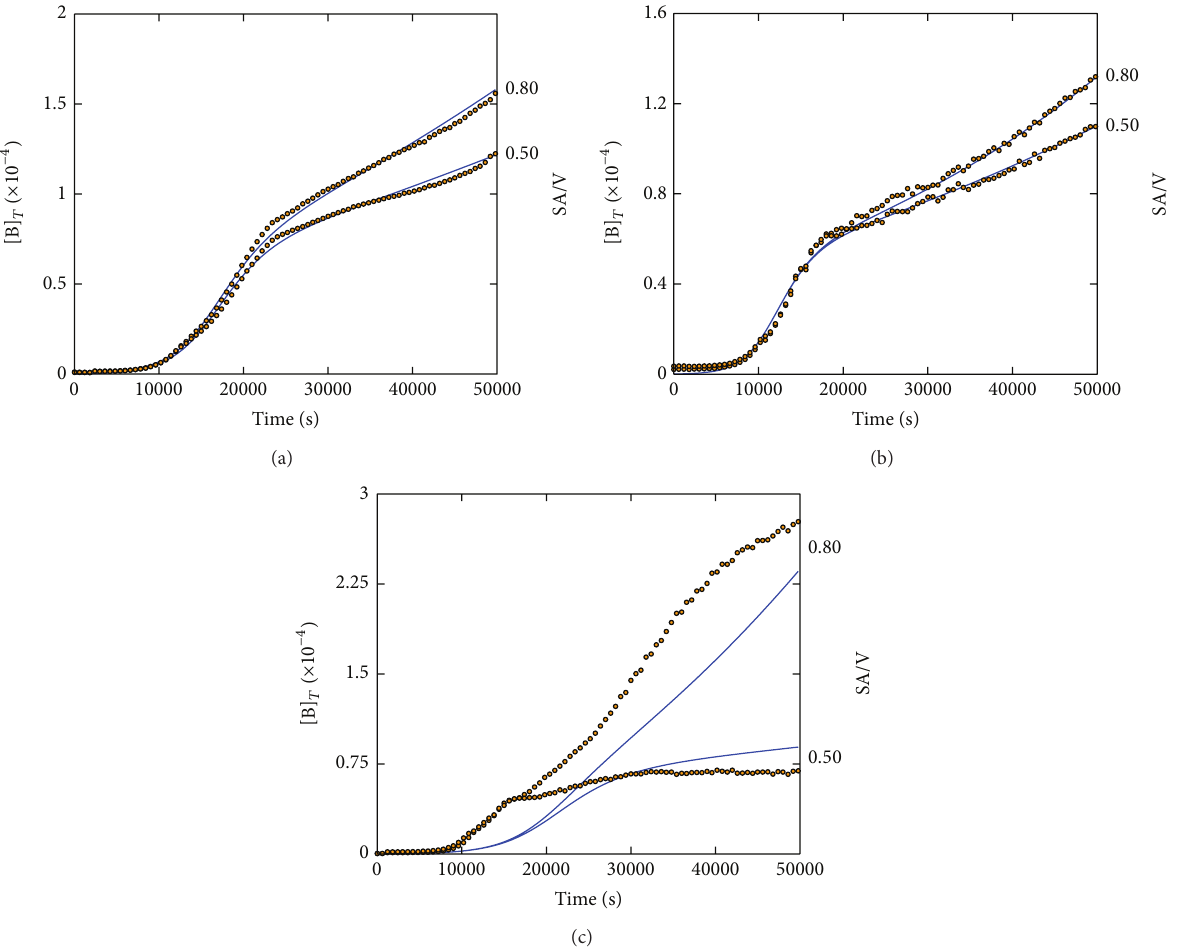
Figure4:Experimentalgrowthcurvesofvariousbacteria(opencircles)bestfittedbytheCKAmodel(solidlines).(a) E.coliJM83 :SA/V = 0 .5 and 0.8 cm −1 , obtained parameter values are given in Table 3. (b) Salmonella typhimurium : SA/V = 0 .5 and 0.8cm −1 , obtained parameter values are given in Table 3. (c) Vibrio cholerae : SA/V = 0 .4 and 1.0cm −1 , shown curves illustrate that a satisfactory data fitting was rejected. All initial concentrations for the simulations are given in Figure